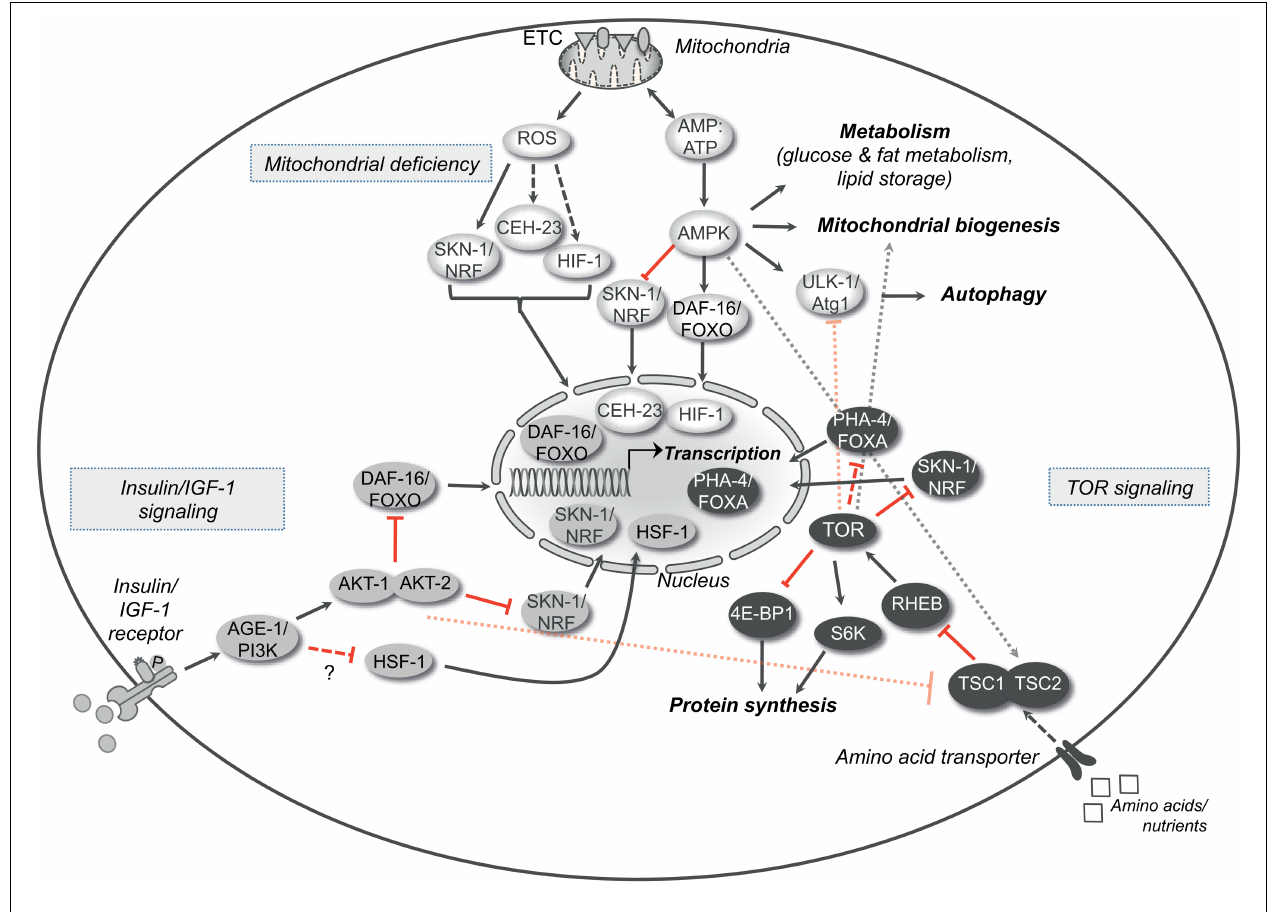
transcription factor; HSF-1, heat shock response transcription factor-1; SKN-1/Nrf, skin in excess transcription factor 1/NF-E2-related factor;TSC1/2, tuberous sclerosis complexes 1 and 2; RHEB, Ras homolog enriched in brain; TOR, target of rapamycin kinase; S6K, S6 kinase; 4E-BP1, eukaryotic initiation factor 4E-binding protein; PHA-4/FOXA, forkhead box A (FOXA) transcription factor; ROS, reactive oxygen species; ATP, adenosine-5 (cid:2) -triphosphate; CEH-23, homeobox transcription factor; HIF-1, hypoxia-inducible transcription factor 1; AMPK, adenosine monophosphate-activated protein kinase; ULK-1/ Atg1, serine-threonine kinase ortholog of the autophagy related kinase 1